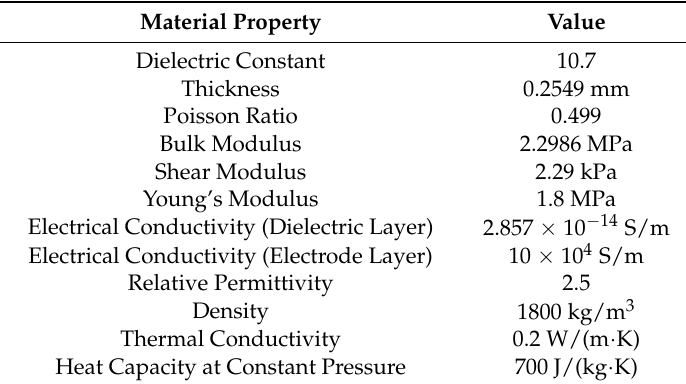
Table 2. Material Property Model Inputs.